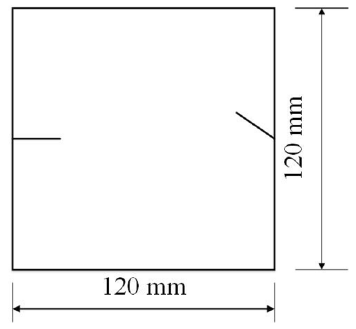
Figure 43. Specimen with two 30 mm long cracks.